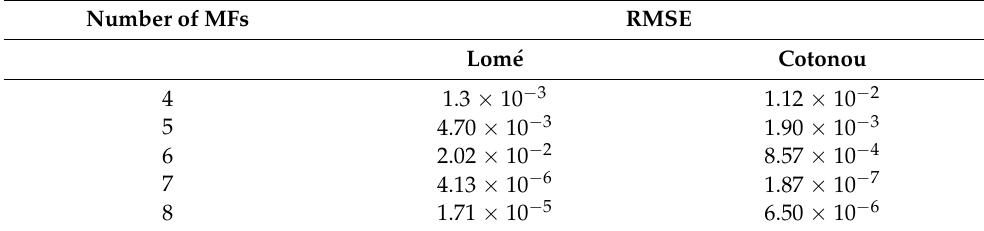
Table 7. Selection of the number of membership